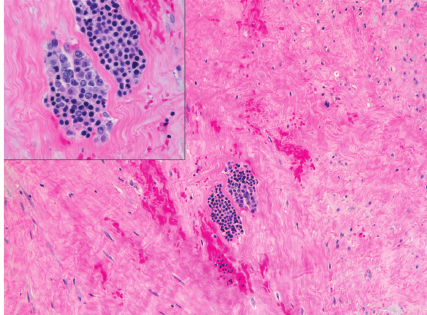
Figure 1: EMH present within smooth muscle of leiomyoma, hematoxylin-eosin stain, magnification 100x (insert 400x).